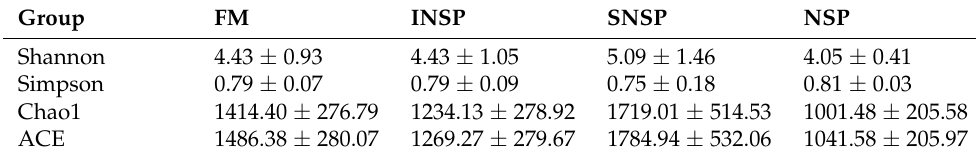
Table 8. Gut microbiota Alpha diversity parameters of grass carp fed by experimental diets.